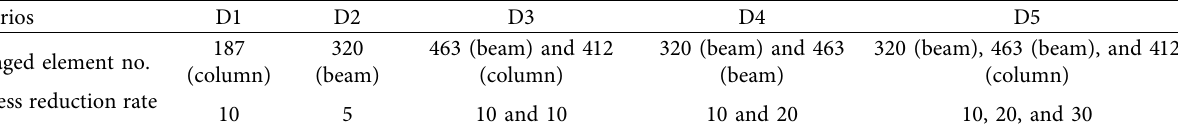
Table 4: Damage scenarios of a 6-storey building with unsymmetrical distribution of columns.